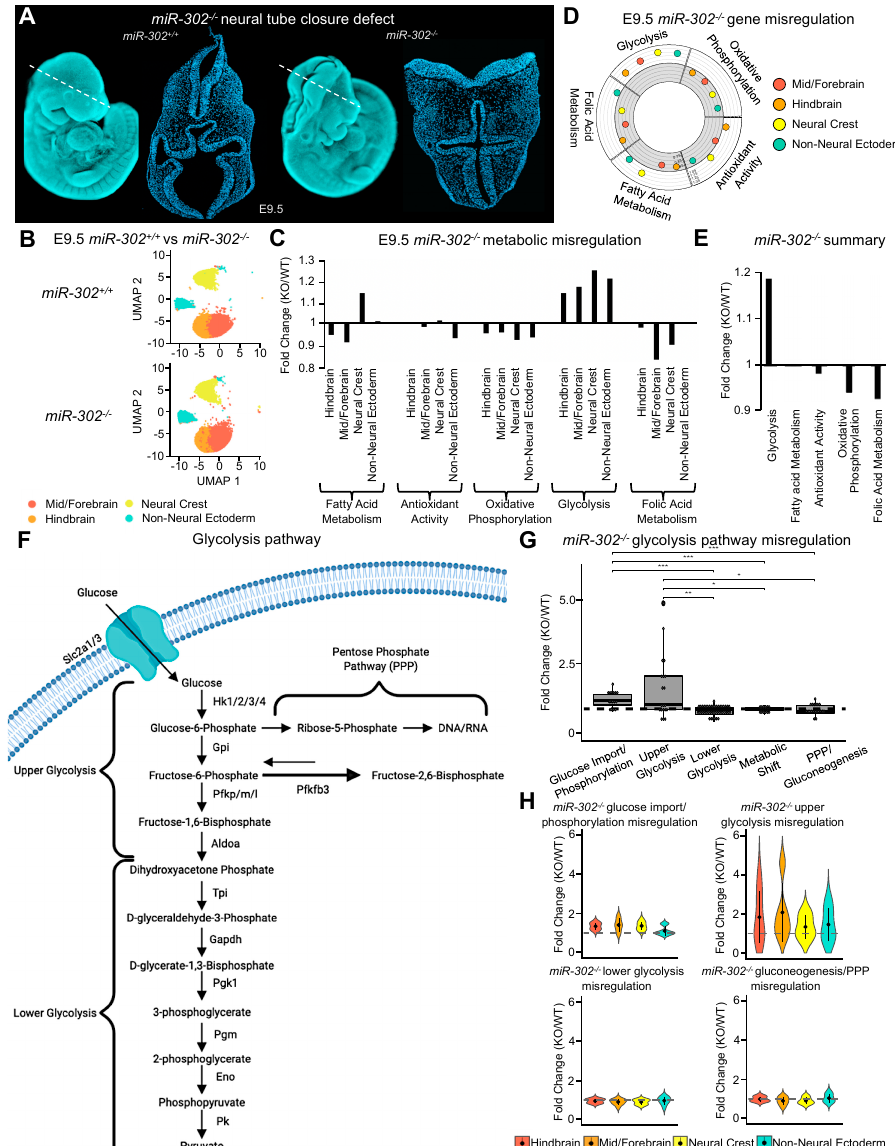
Figure 3. Upper glycolysis is regulated by miR-302 . ( A ) DAPI staining of wildtype and miR-302 knockout embryos in both wholemount and transverse cross section to show the resulting cranial neural tube closure defect. ( B ) UMAP plot comparing ectoderm-derived cell of wildtype and miR-302 knockout embryos at E9.5. ( C ) Bar plot and ( D ) circle plot showing the misregulation of metabolic pathways in ectoderm-derived populations upon miR-302 deletion. ( E ) Bar plot summarizing the misregulation of genes in each metabolic process upon miR-302 deletion. ( F ) Schematic showing the process of glycolysis including glucose import, the pentose phosphate pathway, and upper and lower glycolysis. ( G ) Boxplot of the misregulation of the glycolysis pathway of the miR-302 knockout. ( H ) Violin plots to show population specific misregulation of the glycolysis pathway in the miR-302